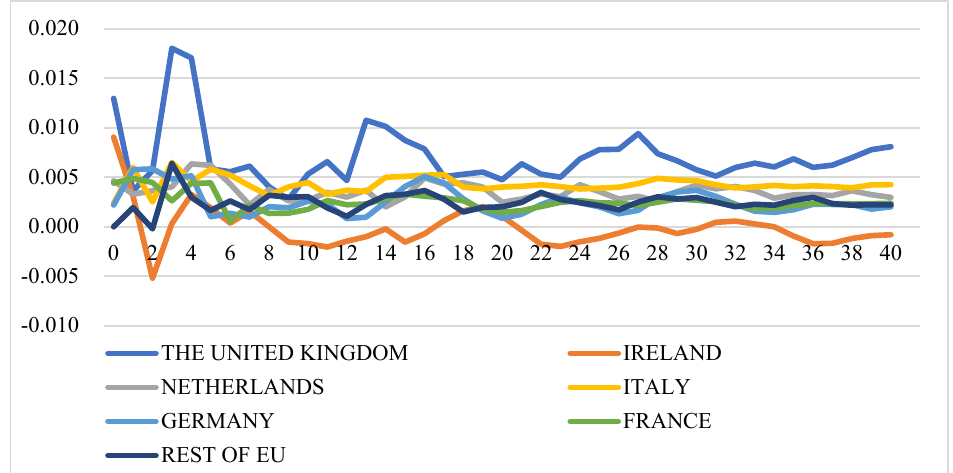
Figure 8. Generalized impulse response functions (GIRFs) of six EU member states’ extra-EU cheese export prices after a positive one-standard-error shock to crude oil price (bootstrap median estimates).